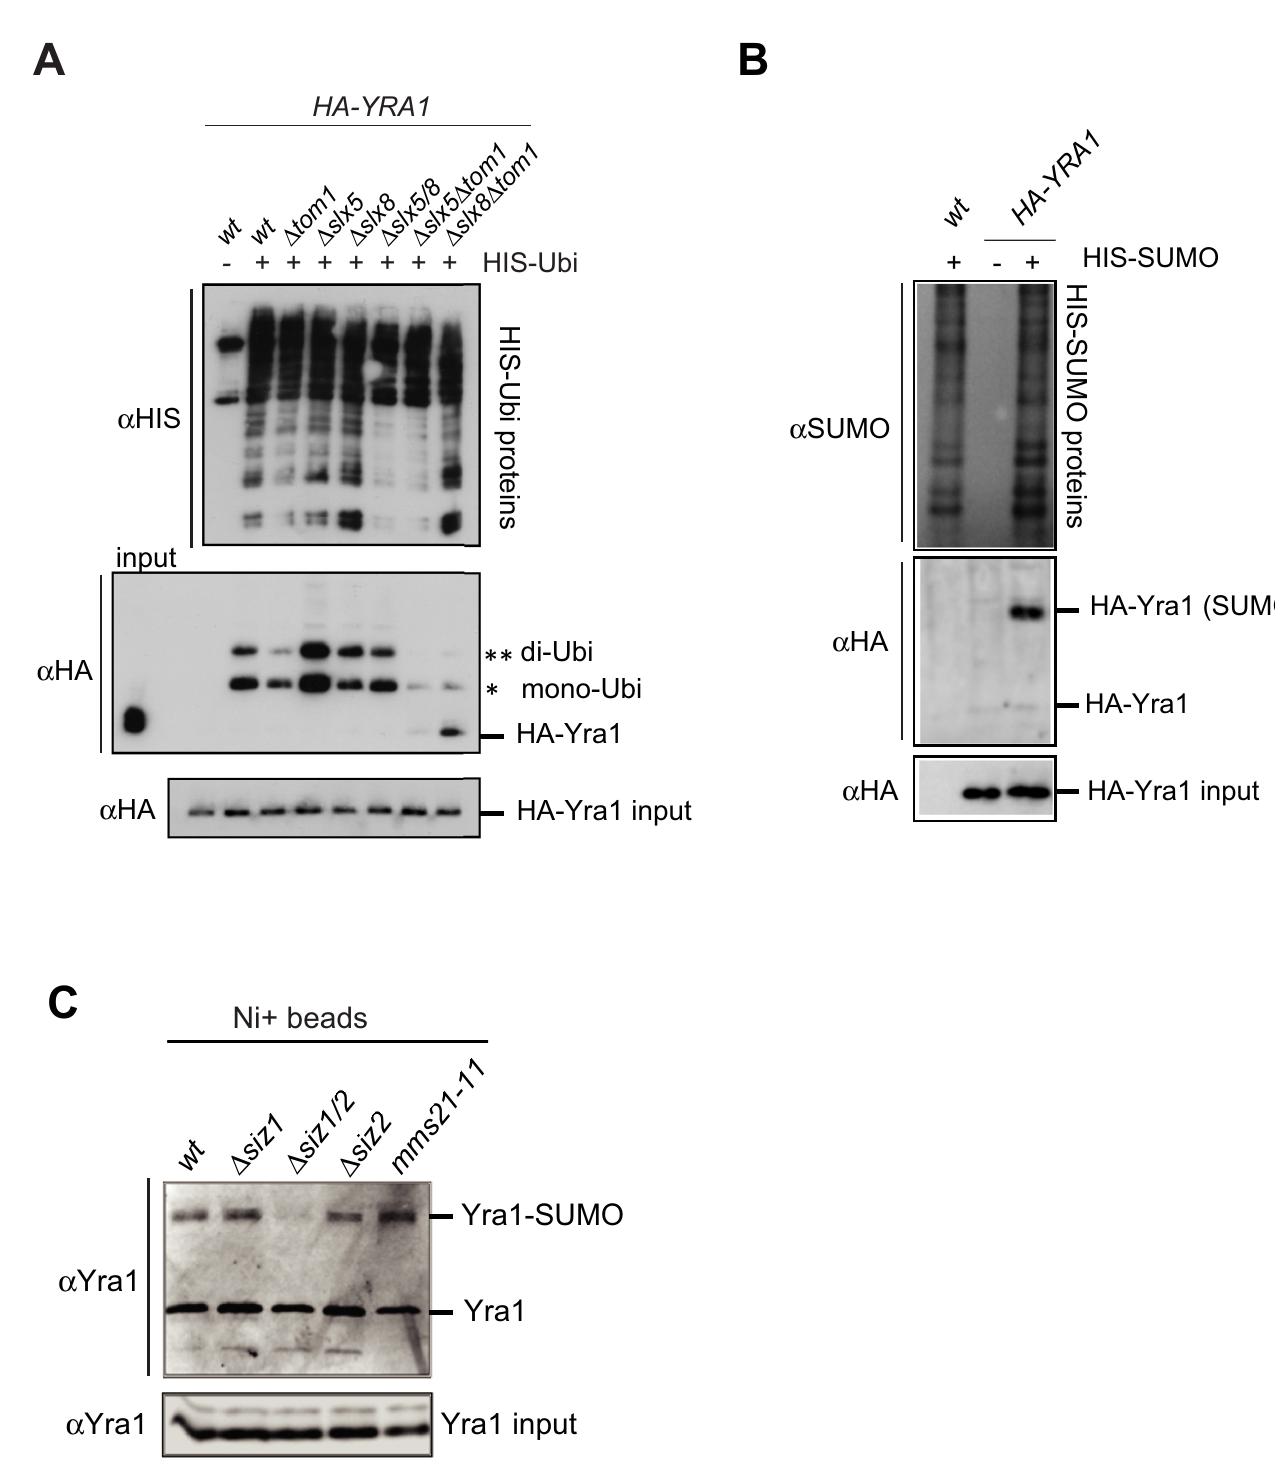
Fig 1. Yra1 is a sumoylated protein targeted for ubiquitination by the SUMO-dependent ubiquitin ligase Slx5-8. (A) Yra1 ubiquitination depends on the STUbL Slx5-Slx8 and Tom1. Ubiquitination assay of shuffled HA-YRA1 in wild-type and in Δ tom1 , Δ slx8 , Δ slx5 , Δ slx8 Δ tom1 , Δ slx5 Δ tom1 and Δ slx8 Δ slx5 mutant backgrounds. His-Ubiquitinated proteins were affinity-purified and the Ubiquitinated forms of Yra1 detected by Western Blot with α HA antibodies. One representative experiment of 3 is shown. (B) Yra1 is sumoylated. Sumoylation assay in wild-type and HA-YRA1 backgrounds. His-sumoylated proteins were affinity-purified and the sumoylated forms of Yra1 detected by Western Blot with α HA antibodies. One representative experiment of 3 is shown. (C) Yra1 is